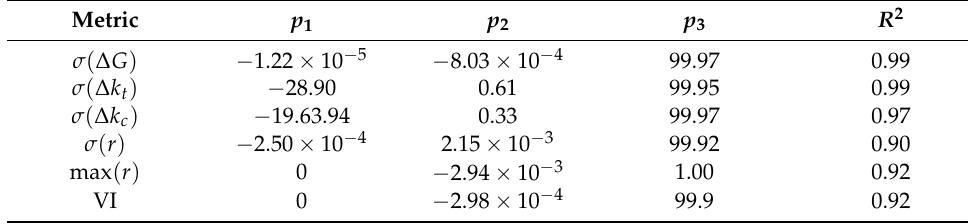
Table A1. Parameters of the binned efficiency